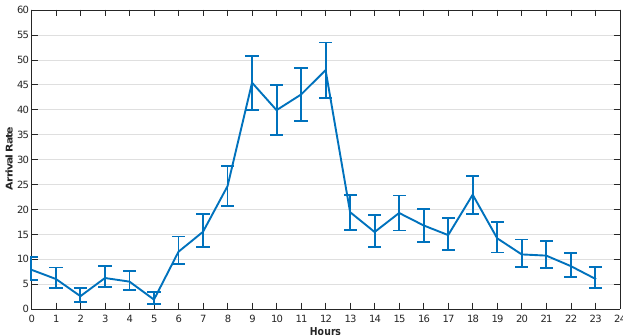
Figure 7. The Arrival Rate in 24 h, Square id 100, Milan, 1 November 2013.